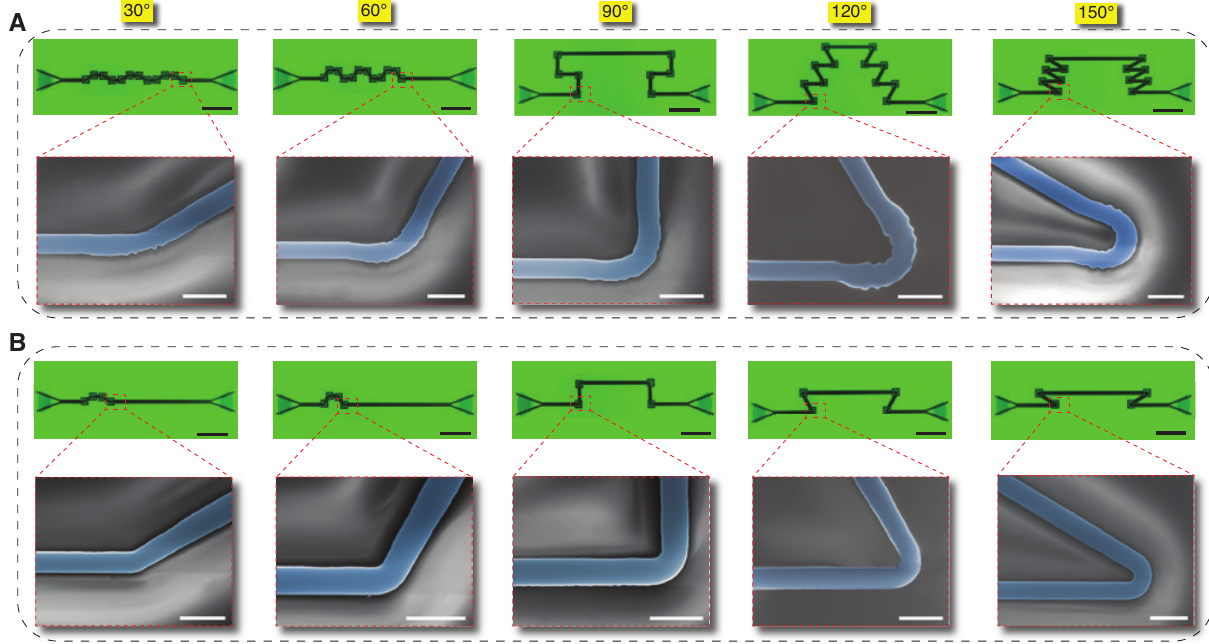
Figure 3: Device images of the photonic welding points and waveguide bends. (A) Optical microscope and SEM images of the fabricated devices for measuring the transmission loss of photonic welding points connecting two waveguides with bending angles of 30 ° , 60 ° , 90 ° , 120 ° , and 150 ° . The devices with bending angles of 30 ° , 60 ° , 120 ° , and 150 ° each contain 12 photonic welding points, whereas the one with bending angle of 90 ° contains 8 photonic welding points. (B) Optical microscope and SEM images of the fabricated devices for measuring the transmission loss of waveguide bends connecting two waveguides with bending angles of 30 ° , 60 ° , 90 ° , 120 ° , and 150 ° . Each device contains four cascaded bends for reducing the measurement error. Scale bars represent 40 μ m in all optical microscope images and 1 μ m in all SEM